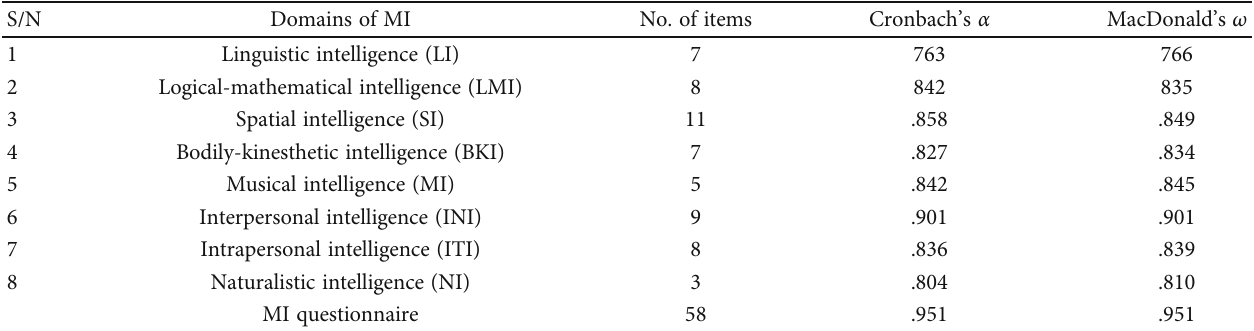
Table 1: Reliability for the domains of multiple intelligences.